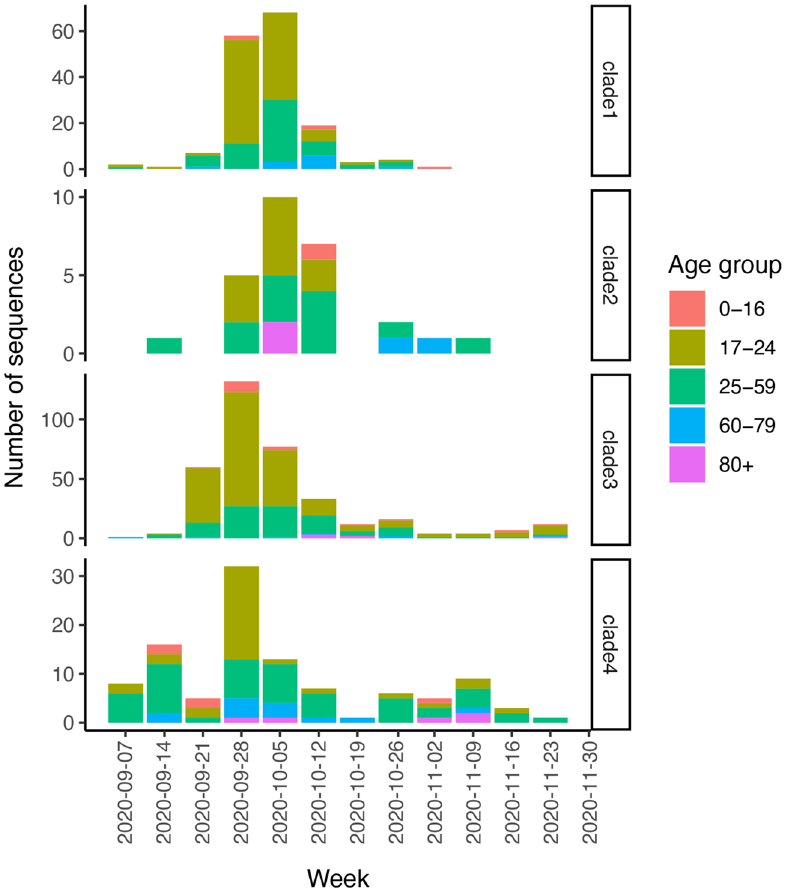
Figure 7. Age distribution of SARS-CoV-2 cases among residents of NHS Greater Glasgow and Clyde with sequences that phylogenetically clustered with each University of Glasgow (UoG) student transmission clade. UoG student cases were excluded. Numbers of sequences informing this analysis were as follows: Clade 1 n = 163, Clade 2 n = 27, Clade 3 n = 362, Clade 4 n =